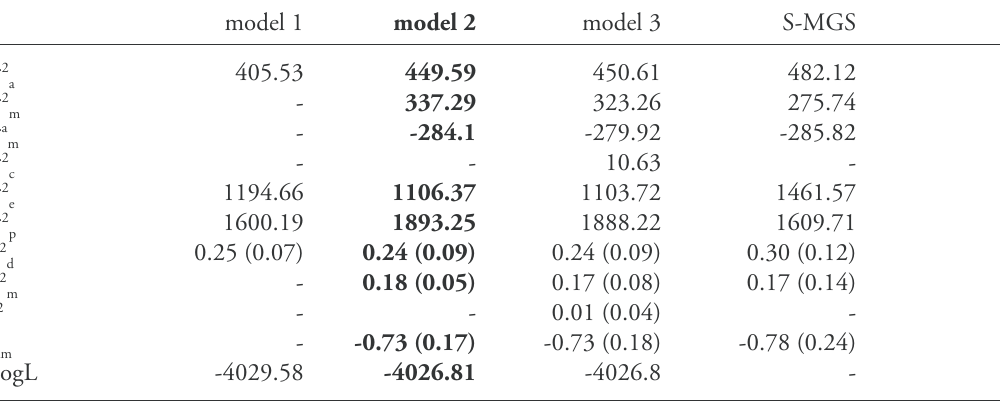
s 2 = direct additive genetic variance, s 2 = maternal additive genetic variance, s a m tive genetic covariance, s 2 = the variance of maternal permanent effect, s 2 c typic variance, h 2 = direct heritability (= s 2 / s 2 ) , h 2 = maternal heritability (= s 2 d a e m due to maternal permanent environmental effects as proportion of total variance, r genetic correlation, LogL = the log likelihood value.